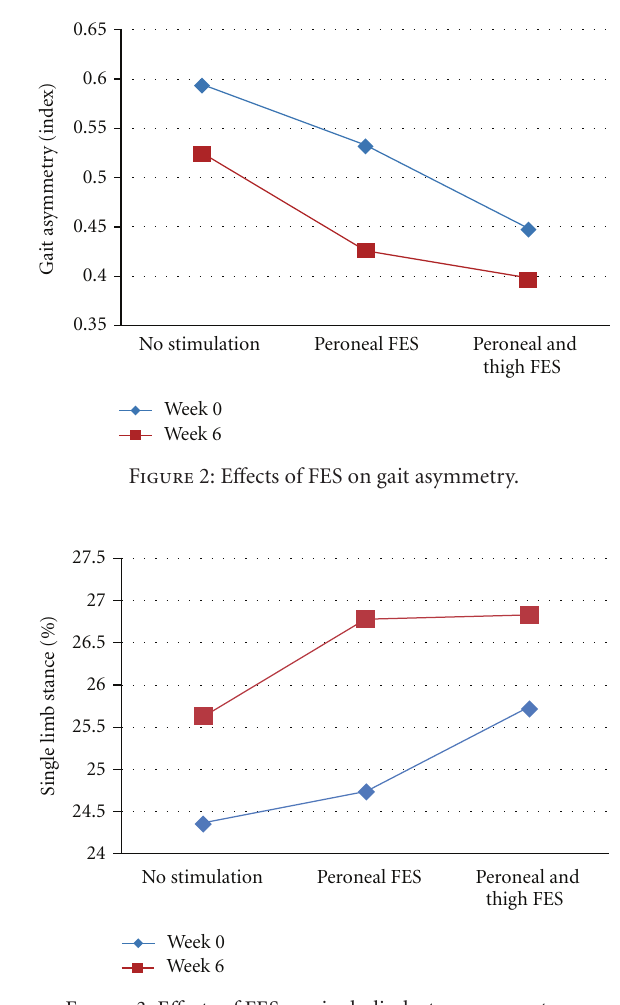
Figure 3: E ff ects of FES on single-limb stance